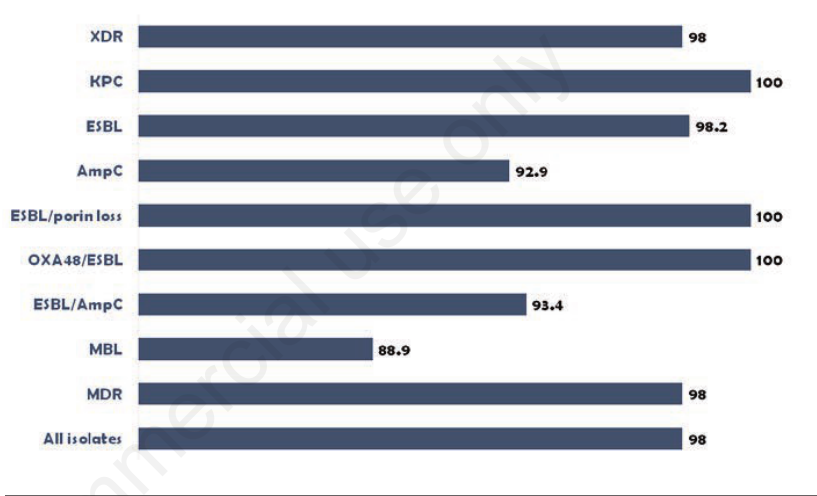
Figure 1. Susceptibility rates (%) of multiple drug resistance, extensively drug resistance, extended spectrum beta-lactamase, class C cephal osporinases (AmpC), OXA48, mannan-